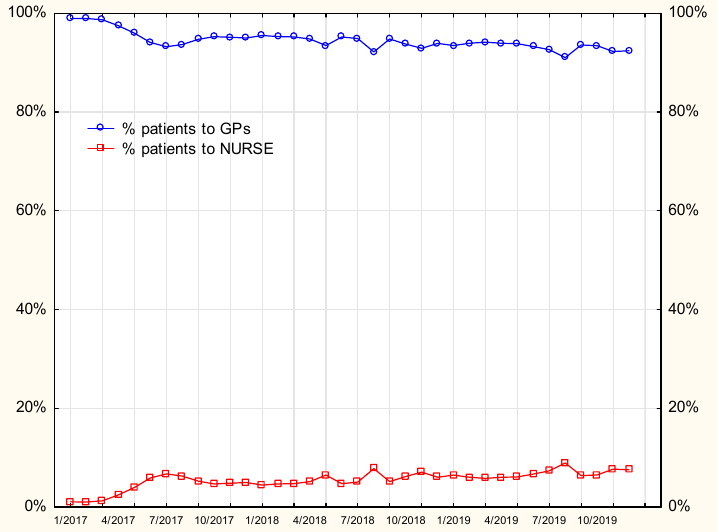
Figure 12. Percentage of patients visiting the GP or the nurse.